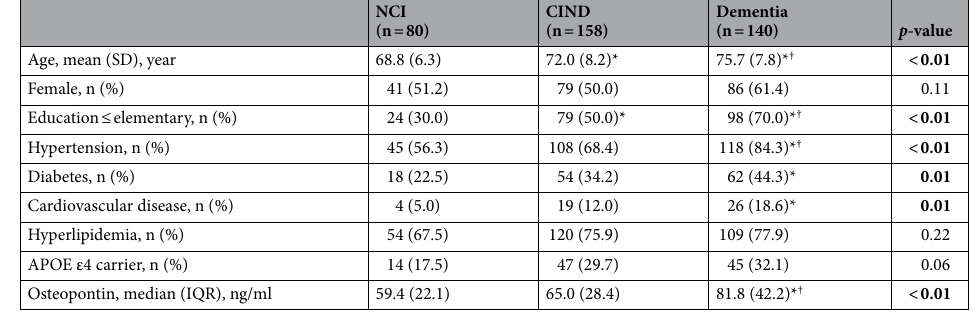
Table 1. Baseline demographic characteristics of control and cases (n = 378). Bold values indicates p < 0.05 using ANOVA or Chi-square tests. CIND, cognitive impairment no dementia; IQR, interquartile range; n, number; NCI, non-cognitive impairment; SD, standard deviation. *Significantly different from NCI ( post-hoc test, p < 0.05). † Significantly different from CIND ( post-hoc test, p <